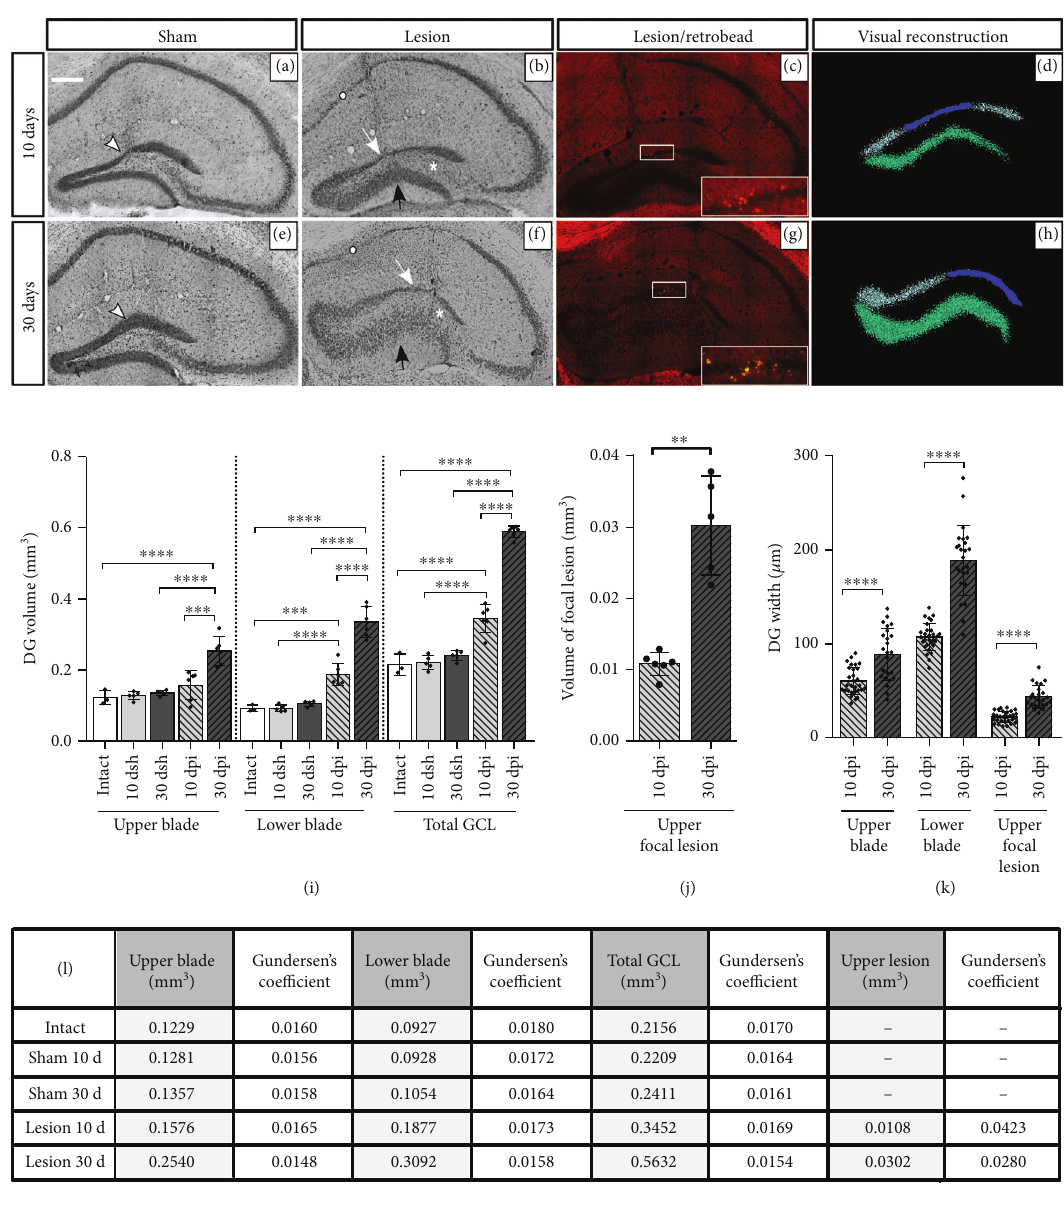
Figure 2: Morphological changes in the DG over time after KA injection. Left images show representative Nissl-stained coronal sections of the hippocampus from (a) 10dsh, (b) 10dpi, (e) 30dsh, and (f) 30 dpi. (a) At 10dsh, sections display a mechanical lesion in the upper blade of DG as result of the cannula insertion (head arrow); scale bars: 300 μ m. (e) At 30 dsh, the mechanical lesion is no longer evident (head arrow). (b) At 10dpi, a focal lesion zone in the upper blade characterized by a thinning of the granule cell layer is observed (white arrow). Outside this lesion area, the upper blade shows GCL widening. (f) At 30dpi, both DG blades display a more severe widening compared to 10 dpi. The black arrows indicate the prominent widening in the lower blade. The white circle and the asterisk symbols indicate cell loss in CA1 and in the hilus, respectively. (c – g) The site where KA spreads in the upper blade as revealed by the fl uorescent tracer; insets show 40x magni fi cations. (d – h) A visual model of the DG based on Nissl-stained coronal sections: upper blade in gray, lesion site in blue, and lower blade in green. (i) Volume of the DG based on Cavalieri analysis (intact n = 3 ; 10 dsh n = 5 ; 30dsh n = 5 ; = 123 : 7 , p < 0 : 0001 ). (j) Volume from the 10dpi n = 6 ; 30dpi n = 5 ; one-way ANOVA followed by Bonferroni ’ s post hoc test, F ð 14,60 Þ lesion site in the upper blade from KA-injected mice (10 dpi n = 6 ; 30 dpi n = 5 ; unpaired t -test with Welch ’ s correction, F ð = 4,5 Þ 18 : 31 , p < 0 : 0069 ). (k) GCL width from each DG section analyzed in KA-injected mice (10dpi n = 29 sections from 6 mice; 30dpi n = 24 sections from 5 mice; unpaired t -test with Welch ’ s correction; upper blade, F ð = 3 : 625 , p = 0 : 0015 ; lower blade, F ð = 6 : 493 , p < 23,28 Þ 24,28 Þ 0 : 0001 ; upper blade focal lesion, F ð = 3 : 962 , p = 0 : 0007 ). (l) Average volume and Gundersen ’ s coe ffi cient after a stereological Cavalieri 23,28 Þ analysis from the same mice used in histograms (i, j); statistical signi fi cances are indicated in histograms (i, j). A Gundersen ’ s coe ffi cient less than 0.1 means statistically valid volume of data. The columns represent the mean SD from each group. Dots superimposed in the graph represent individual values. Asterisks indicate statistically signi fi cant di ff erences ( ∗ p < 0 : 05 ; ∗∗ p < 0 : 01 ; ∗∗∗ p < 0 : 001 ; ∗∗∗∗ p < 0 : 0001